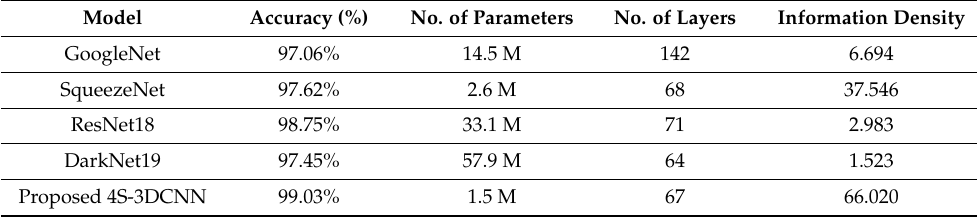
Table 5. Information density comparison along with accuracy, number of parameters, and layers of the proposed 4S-3DCNN model with fine-tuned models.